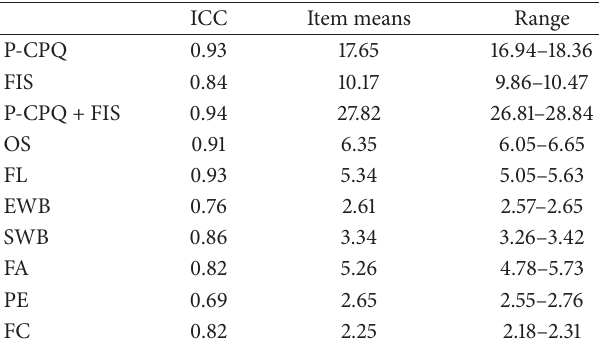
Table 3: Test-retest reliability measured for the total P-CPQ and FIS and for their domains: intraclass correlation coefficients (ICCs), item means, and item